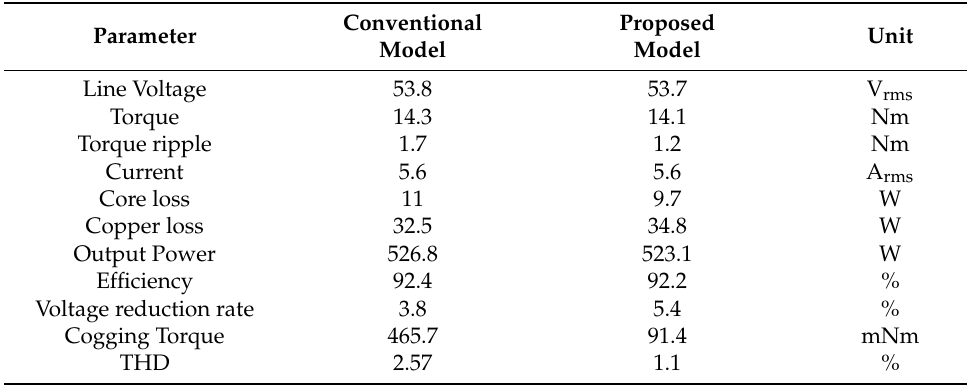
Figure 13. Final model ( a ) stator and rotor, ( b ) core magnetic flux density plot. Table 4. Comparison of FEA performance of the conventional and final models.